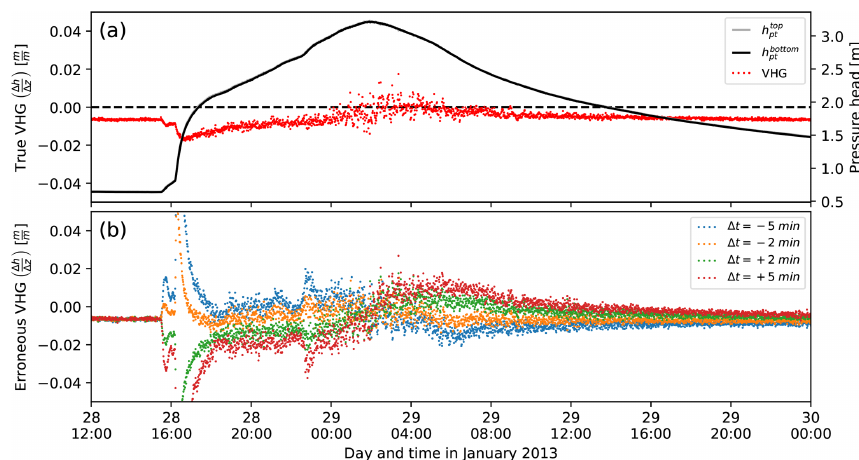
Figure 10. The influence of clock stability on calculating a vertical head gradient: (a) pressure heads measured in a streambed using two PTs (note that the two lines are too close together to distinguish) with clocks that are in sync and the calculated vertical head gradient. (b) Erroneous vertical head gradients arising from time differences (cid:49)t due to out-of-sync instrument clocks caused by clock drift (the data were synthetically shifted).